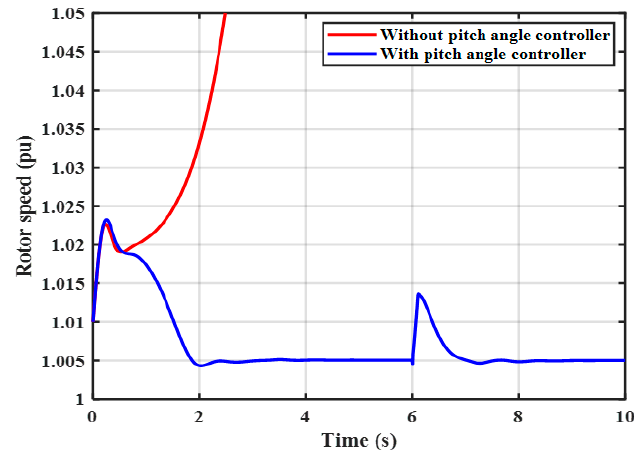
Figure 24. Rotor speed without and with pitch angle controller during LLLG fault.